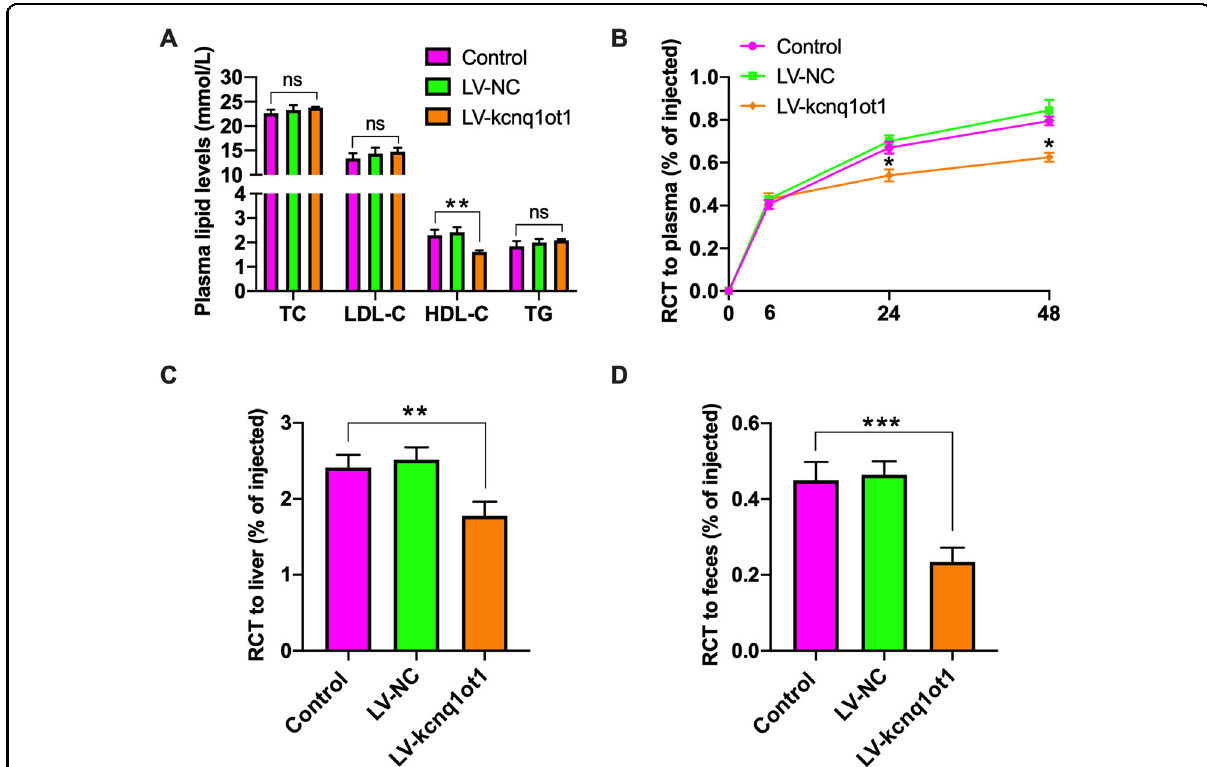
Fig. 2 Effects of kcnq1ot1 on plasma HDL-C levels and RCT in apoE − / − mice. A Plasma levels of TC, TG, HDL-C, and LDL-C were assessed by enzymatic methods ( n = 10 per group). B – D J774 macrophages loaded with [ 3 H]-cholesterol and ox-LDL were injected into the abdominal cavity of apoE − / − mice ( n = 5 per group). The radioactivity in the plasma, liver and feces were measured by a liquid scintillation counter. Data are represented as mean ± SD. * P < 0.05, ** P < 0.01, *** P < 0.001; ns not signi fi cant vs. control